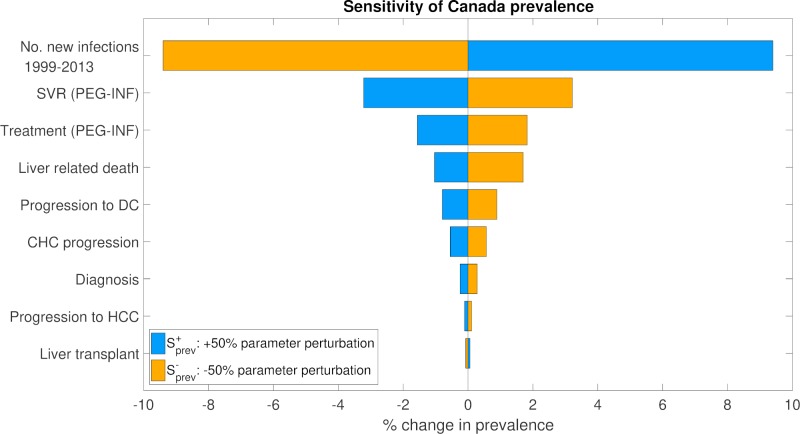
One-way sensitivity analysis for estimated prevalence rate, averaged over all birth cohorts.